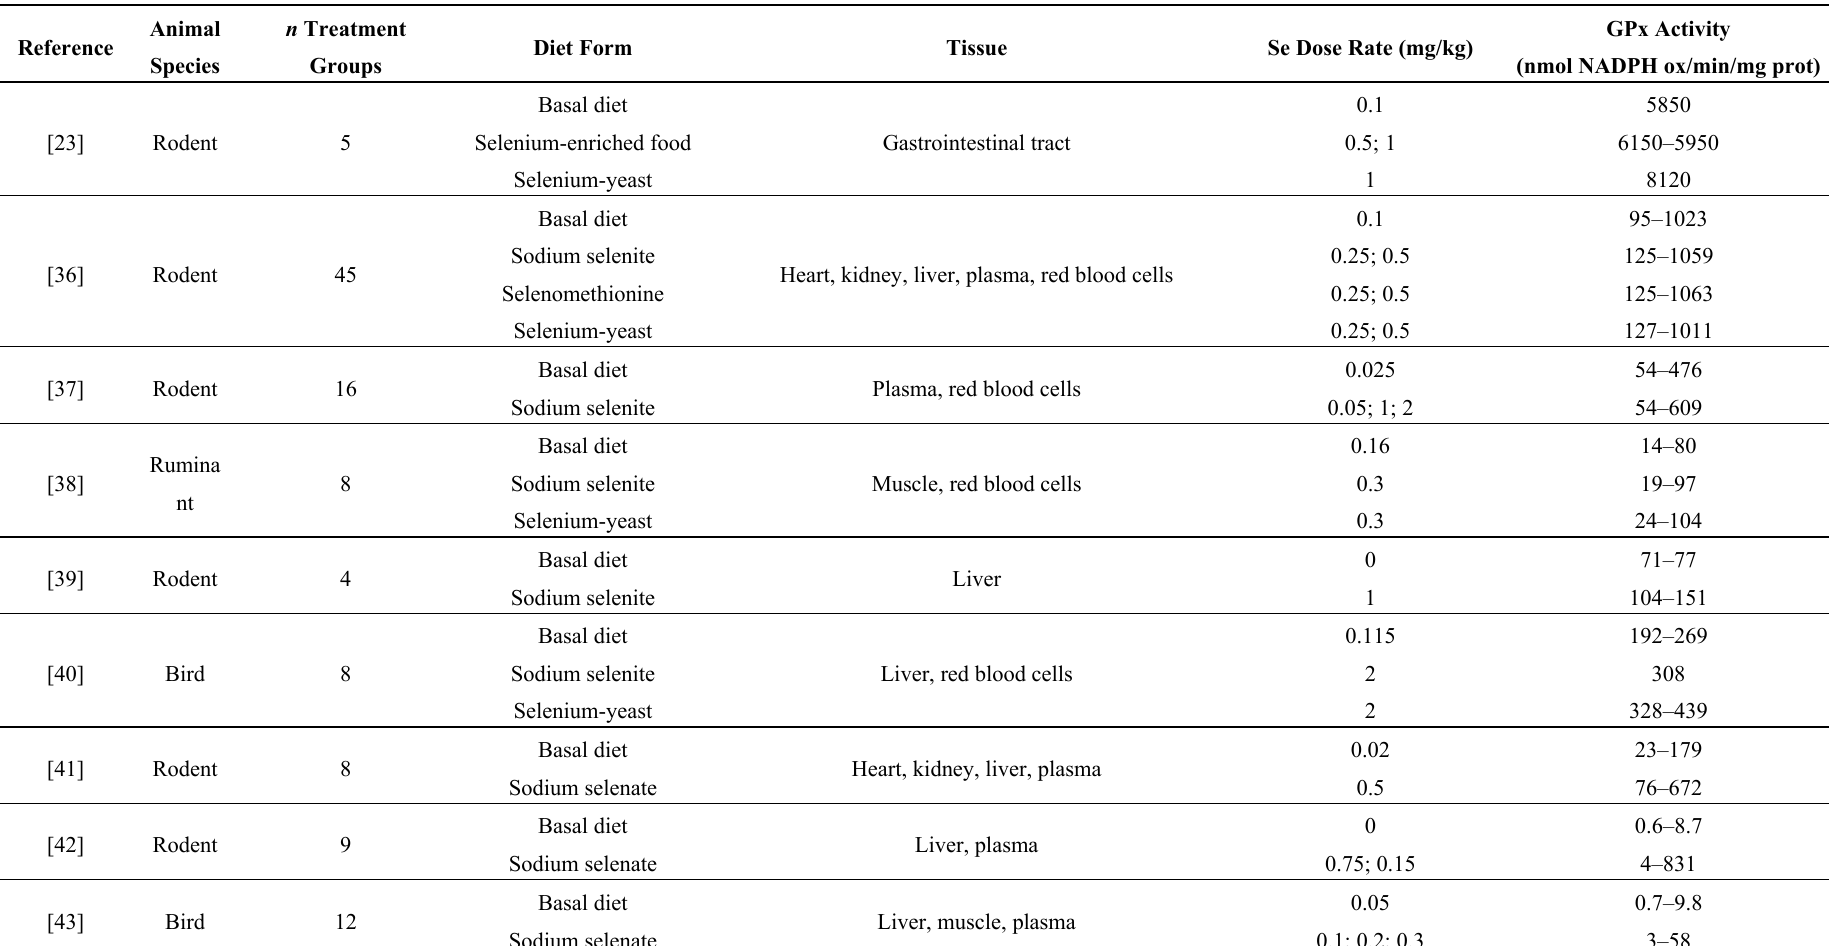
Table 2. Description of the form of selenium studied for selenoprotein activity with changing concentrations of selenium in the diet for animal species and average gluthationine peroxidase (GPx) activity. The table indicates the number of treatment groups for each publication. A full description of the data set including methodology used can be found in Table